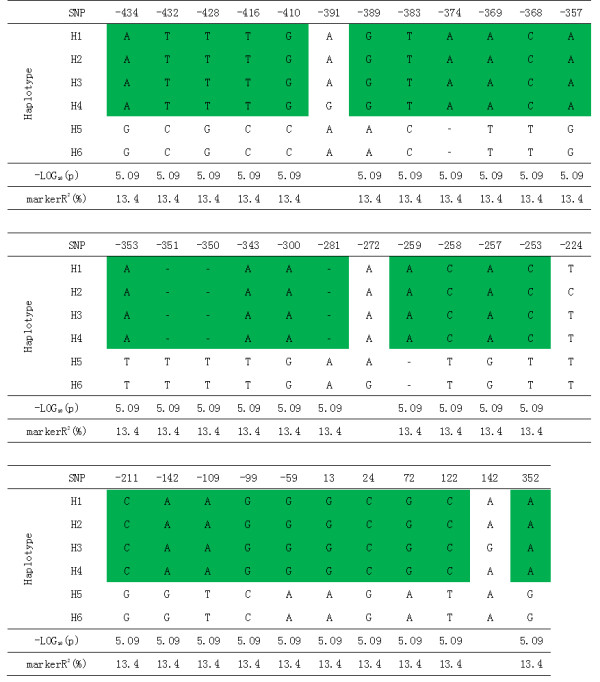
Haplotype analysis of the HvLDI using 35 SNPs. The first site of coding region was presented as 0. The green areas are the SNPs significantly correlated with LDI activity, for which the value of -log10(P) >2. Marker R2 is the fraction of the total variation explained by the marker.